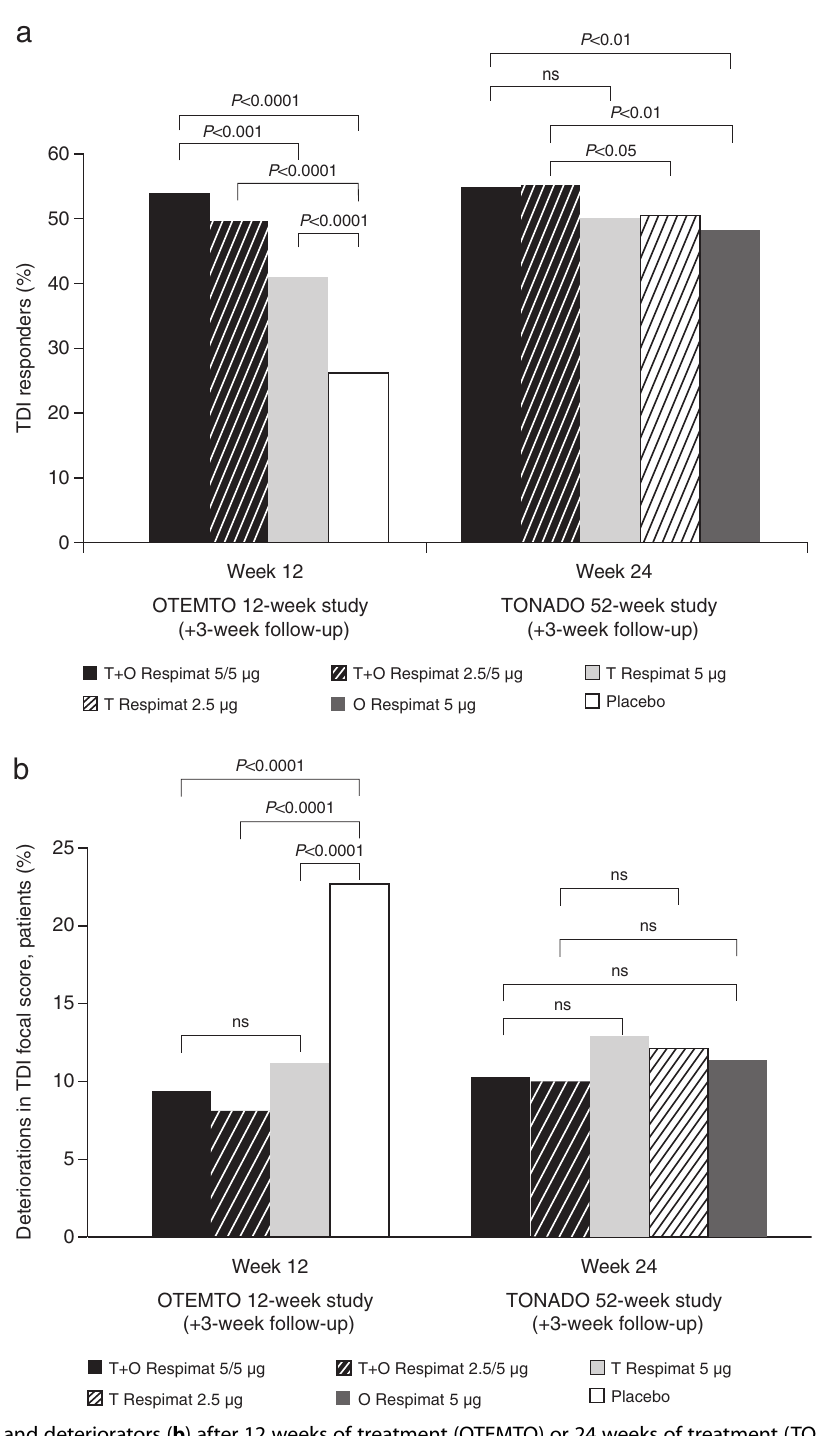
Fig. 1 TDI responders ( a ) and deteriorators ( b ) after 12 weeks of treatment (OTEMTO) or 24 weeks of treatment (TONADO). ns, not signi fi cant; O, olodaterol; T, tiotropium; TDI, transition dyspnoea